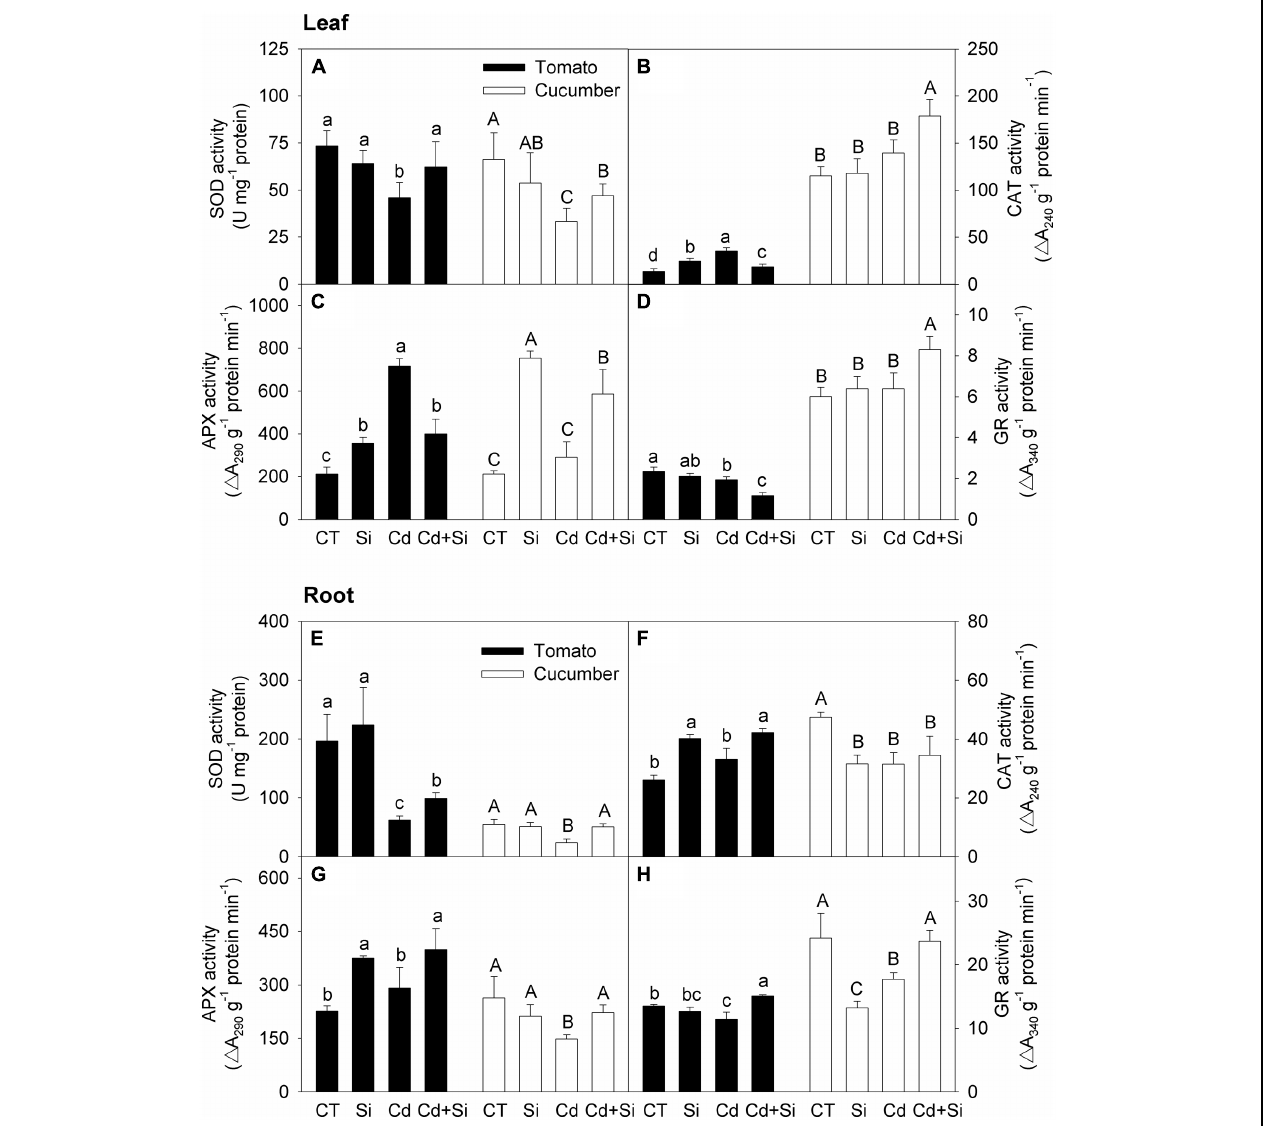
FIGURE 5 | Effects of Si on the activities of SOD (A,E), CAT (B,F), APX (C,G) and GR (D,H) in leaves (A–D) and roots (E–H) in tomato and cucumber under Cd stress. Bars with different letters mean significant difference at P < 0.05 according